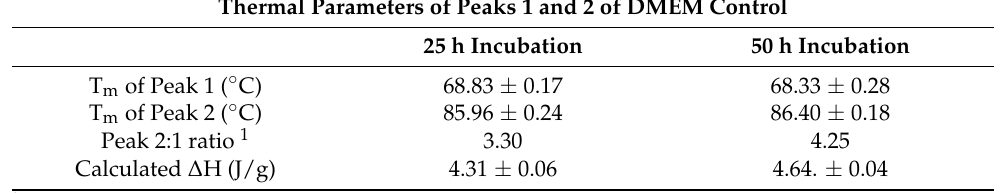
Table 2. Thermal characterization of the primary and deconvolved DSC data of control in the presence Table 1. Thermal characterization of the primary and deconvolved DSC data of human whole blood of DMEM. Mean ± SD ( n = in the absence and presence of SARS-CoV-2. Data represent mean ± SD ( n ≥ 4).